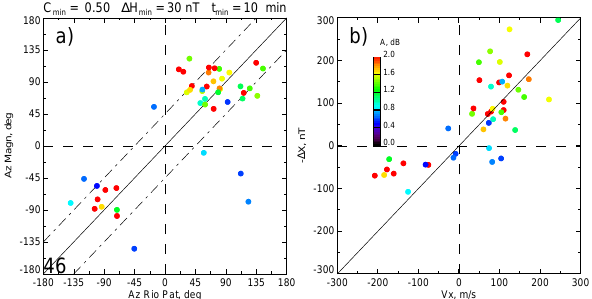
Fig. 4. Panel (a) The same as Fig. 3d but with additional criteria ap- plied. Panel (b) shows the scatter plot of the magnetic perturbations − 1X versus zonal velocity of patch motion V x .